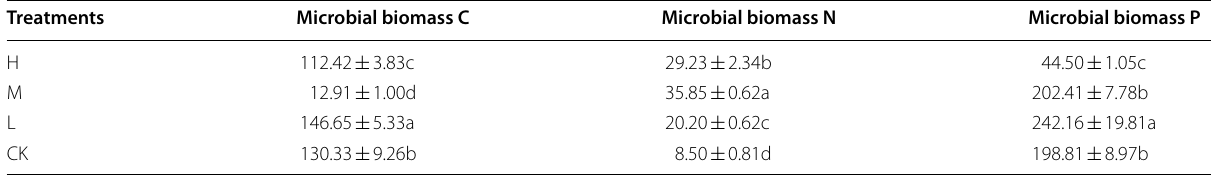
All data are presented as the mean SD (standard deviation) ± H high N application in the sugarcane soil (964 kg ha − 1 ), M medium N application in the sugarcane soil (482 kg ha − 1 ), L low N application in the sugarcane soil (96 kg ha − 1 ), CK no N application in the sugarcane soil (0 kg ha − 1 ) Different letters in the same column indicate significant differences between treatments at P < 0.05 among the means of the four treatments